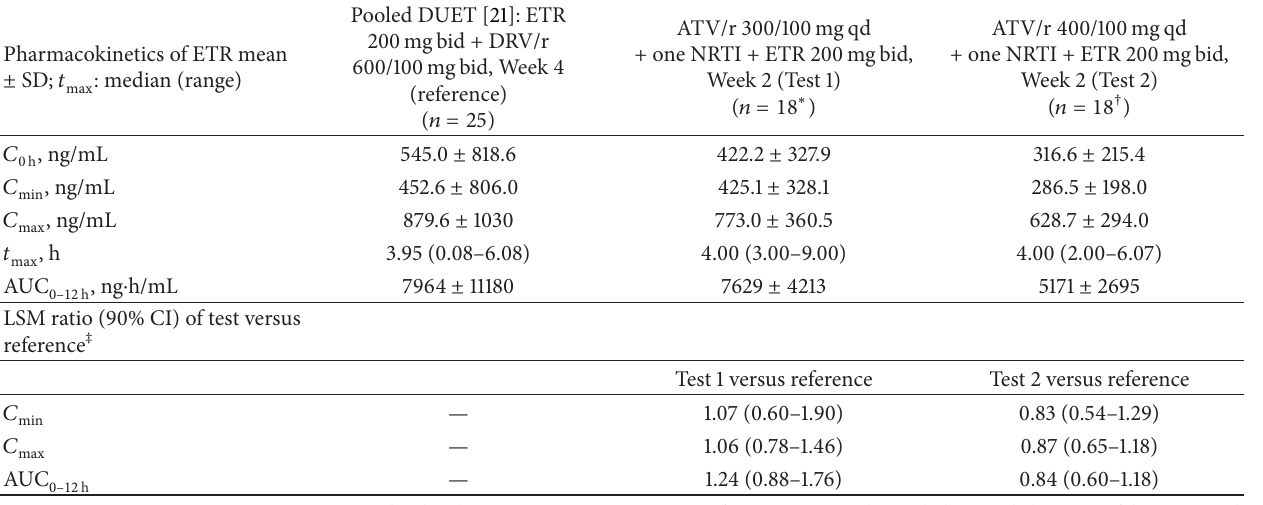
Table 3: Pharmacokinetic parameters and statistical analysis of etravirine after administration of etravirine 200mg bid for two weeks in combination with atazanavir/ritonavir 300/100 mgqd or 400/100 mgqd and one NRTI and from the pooled DUET pharmacokinetic substudies at Week 4